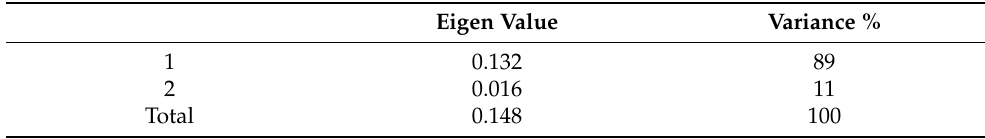
Table 6. Variance and Eigen